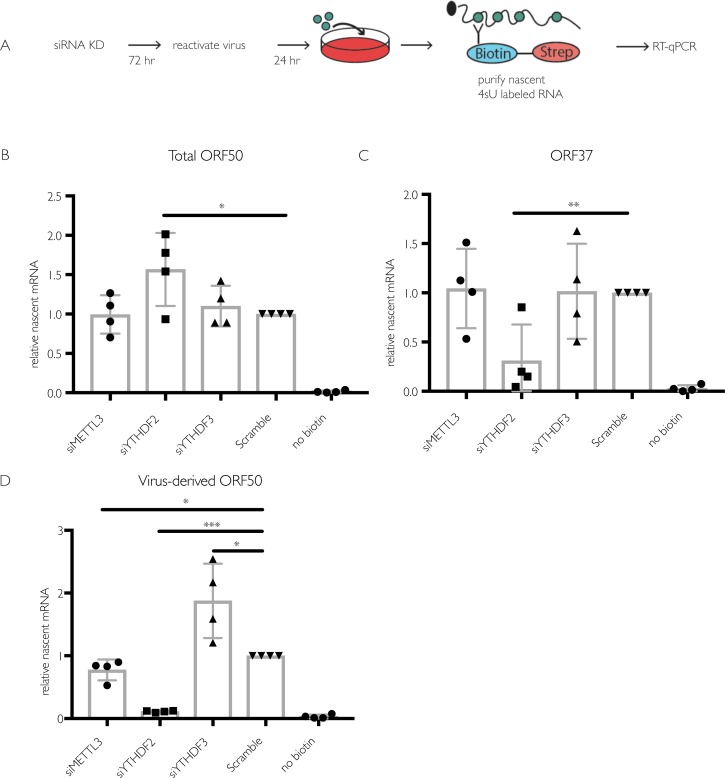
Depletion of the m6A writer and readers does not impact ORF50 nascent transcription in iSLK.219 cells.(A) Schematic of the experimental setup for measuring nascent RNA synthesis. Cells were transfected with the indicated siRNAs for 48 hr then reactivated for 24 hr with dox. 4sU was added for 30 minutes, whereupon 4sU-labeled RNA was isolated using biotin/streptavidin affinity purification, reverse transcribed, and analyzed by RT-qPCR using primers specific to ORF50 or ORF37. (B-D) Levels of 4sU-labeled total ORF50 (B), ORF37 (C), and ORF50 transcribed from the viral genome (virus-derived) (D) determined as described above. Unpaired Student’s t test was used to evaluate the statistical difference between samples. Significance is shown for P values <0.05 (*), ≤ 0.01 (**), and ≤ 0.001 (***).